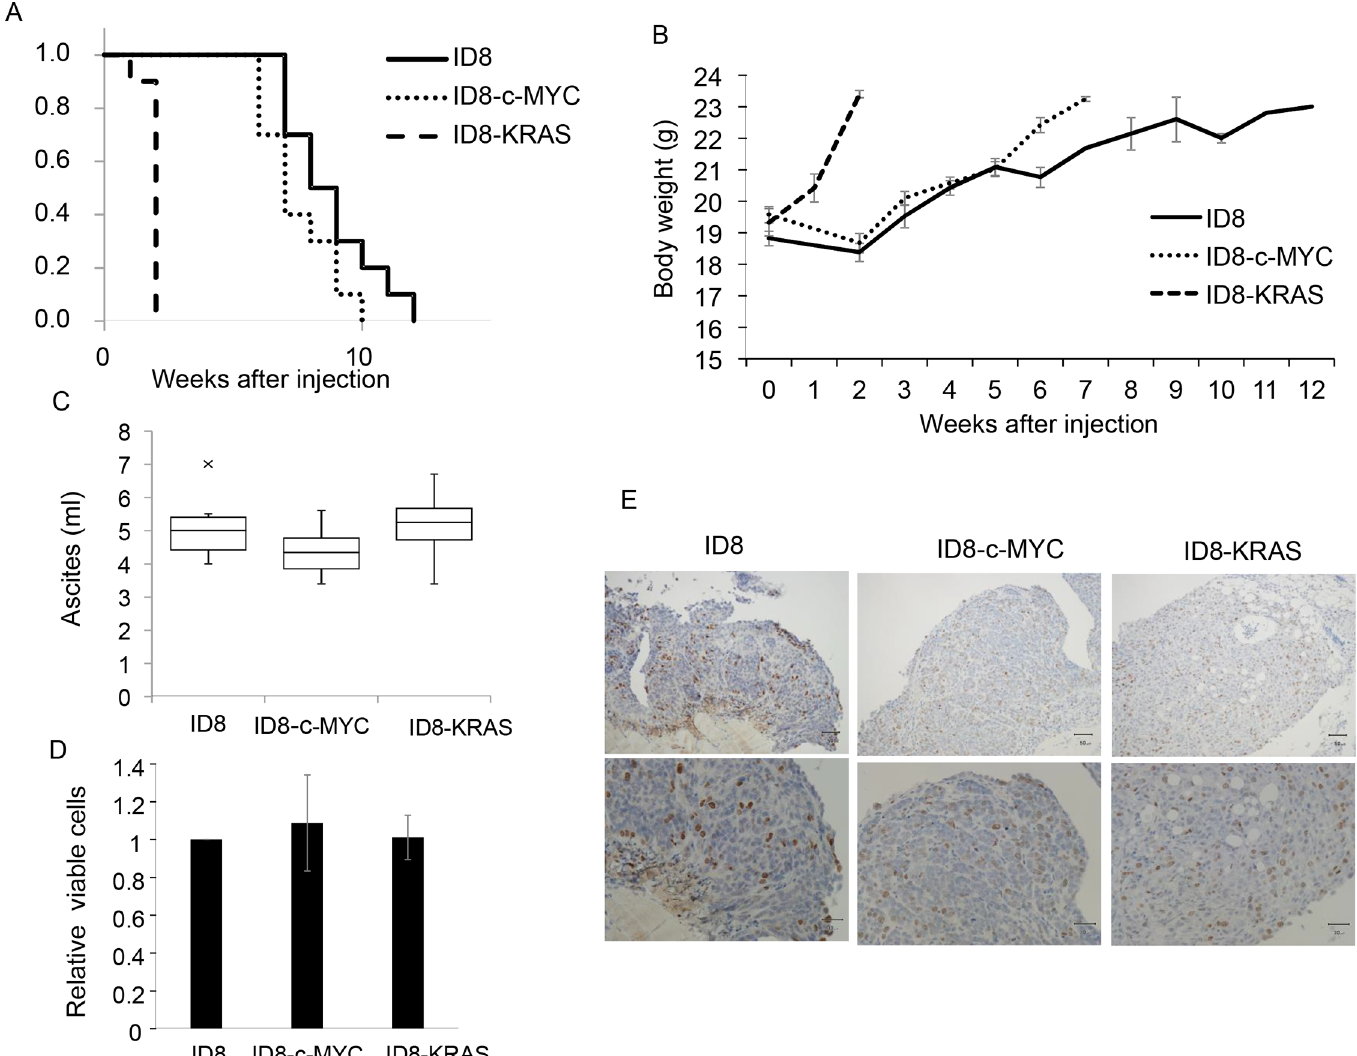
Fig 1. In vivo and in vitro characteristics of oncogene-transduced ID8 cells. (A, B, C) ID8, ID8-c-MYC, or ID8-KRAS cells (2 × 10 6 ) were intra-peritoneal injected into C57/BL6 mice (ID8 group: n = 10, ID8-c-MYC group: n = 10, ID8-KRAS group: n = 10). ID8-KRAS mice were monitored every other day, and ID8 and ID8-c-MYC mice were monitored twice a week. Mice were sacrificed when the body weight reached 23 g. (A) The graph demonstrates Kaplan-Meier curve. The end point was when mice BW reached 23 g in each group. (B) The graph demonstrates that transition of BW in each group when mice BW reached. (C) The graph demonstrates the amount of ascites when BW in each group reached 23 g. Ascites weights were assessed using the following formula: (ascites weight) = (BW with ascites) — (BW without ascites). (D) ID8, ID8-c-MYC and ID8-KRAS cells were plated on 96-well culture plates at aconcentration of 5×10 4 cells/ml and cultured for 48 h. The proliferation of ID8, ID8-c-MYC, and ID8-KRAS cells was assessed by cell proliferation assay. Each experiment was performed in triplicate and repeated 3 times. The average of three trials is shown. Error bars represent the mean ± SEM. (E) ID8, ID8-c- MYC, or ID8-KRAS cells (2 × 10 6 ) were intra-peritoneal injected into C57/BL6 mice. Mice were sacrificed when the body weight reached 23 g. Disseminations were obtained from mice when sacrificed. Proliferation of tumor cells of each dissemination was assessed using Ki67 immunohistochemistry (IHC). Scale bars represent 50 μ m and 30 μ m at low and high magnification,